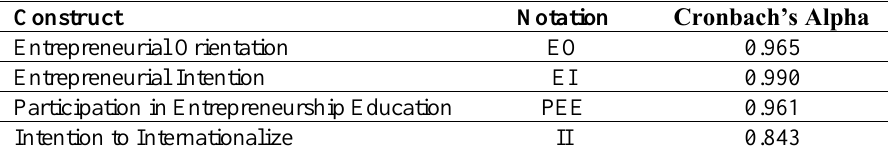
Table 03: Cronbach’s Alpha Values for Pilot